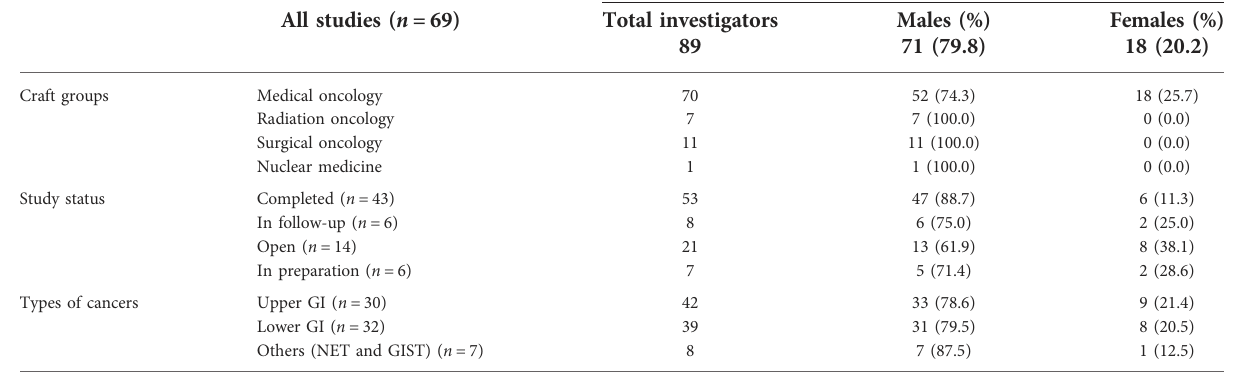
TABLE 1 Distribution of principal investigators for AGITG